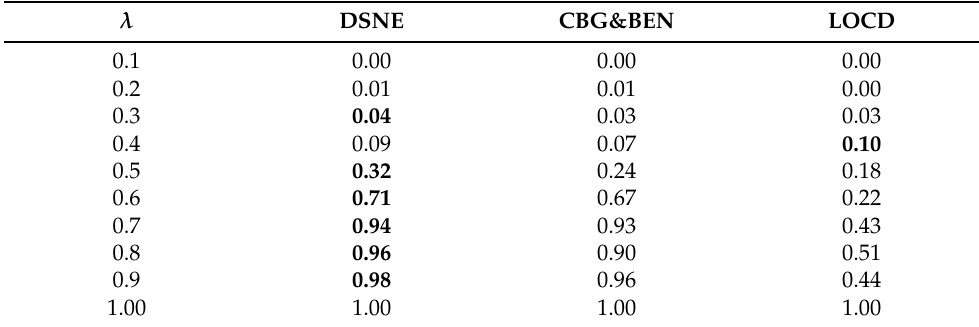
Table 1. Normalized Mutual Information Index (NMI) evaluation of the experimental results of three methods in artificially-generated network with different indexes λ